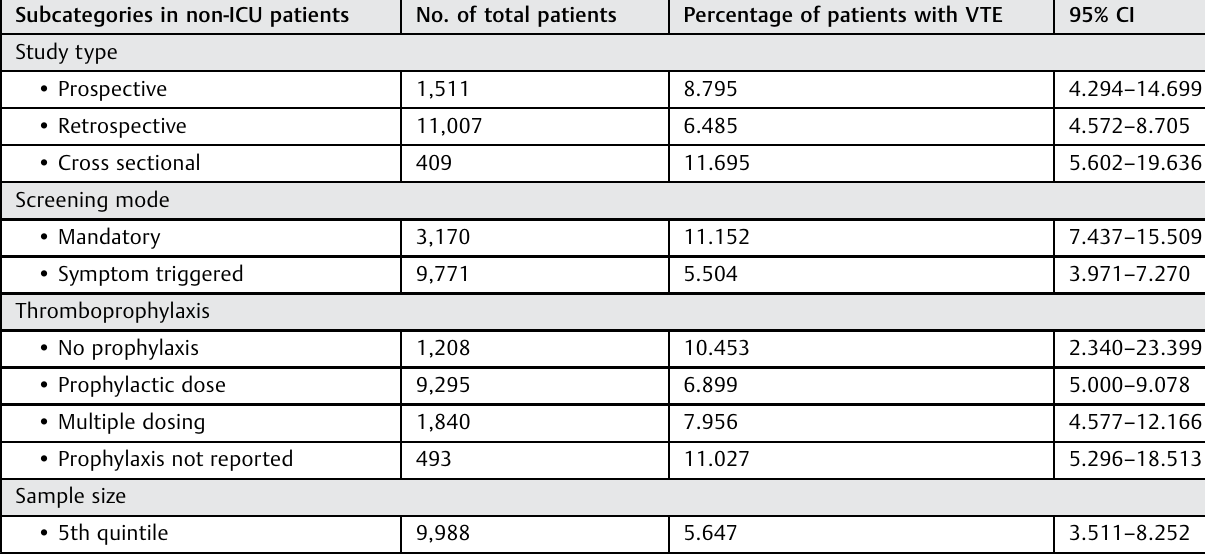
Table 5 Proportion of non-ICU COVID-19 patients with venous thromboembolism: sensitivity analysis Subcategories in non-ICU